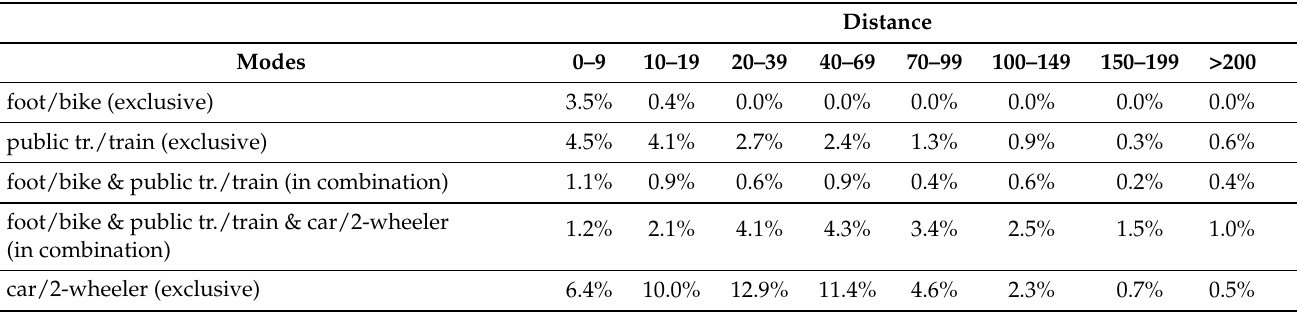
Table 3. Transport modes and distances - total values for the four cities (Detailed data for the four cities are listed in the Additional